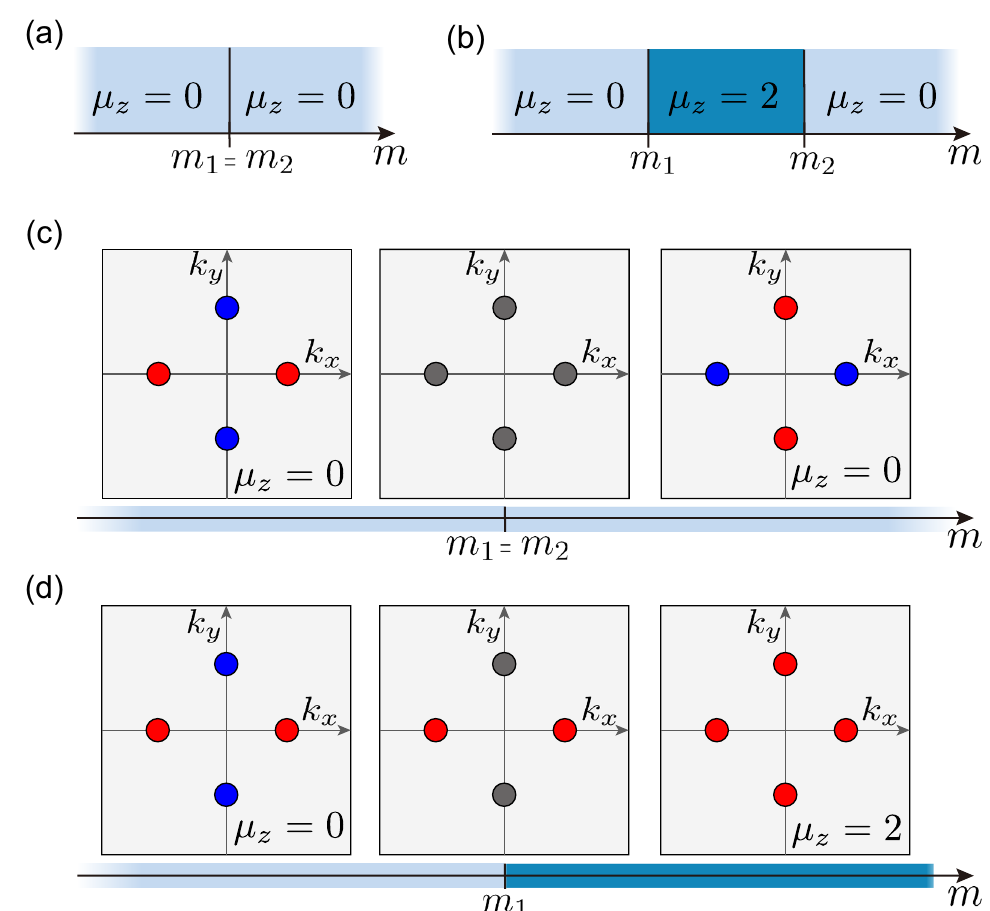
Figure 4. Schematic phase diagrams for a topological crystalline phase transition diagnosed by mirror Chern number µ z . ( a ) Systems with C 4 z . The Dirac and spectator Dirac points that close the band gap simultaneously m 1 m 2 result in the same topological crystalline phases with the mirror Chern number C M at m = = Systems without C 4 z . The Dirac and spectator Dirac points that close the band gap independently at m m 2 m 1 can mediate a topological phase transition from µ z and m = �= Dirac fermions in the mirror-invariant plane of momentum space: ( c ) with C 4 z and ( d ) without C 4 z . The red and blue circles represent the massive Dirac and the massive spectator Dirac fermions, respectively. The grey circles indicate the massless Dirac